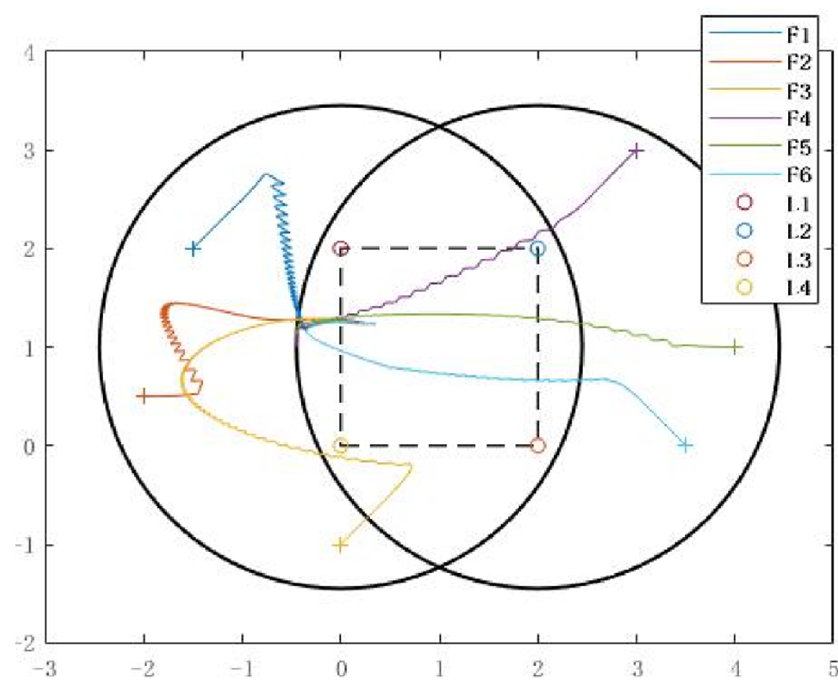
Figure 4. Position states x i ( k ) of all